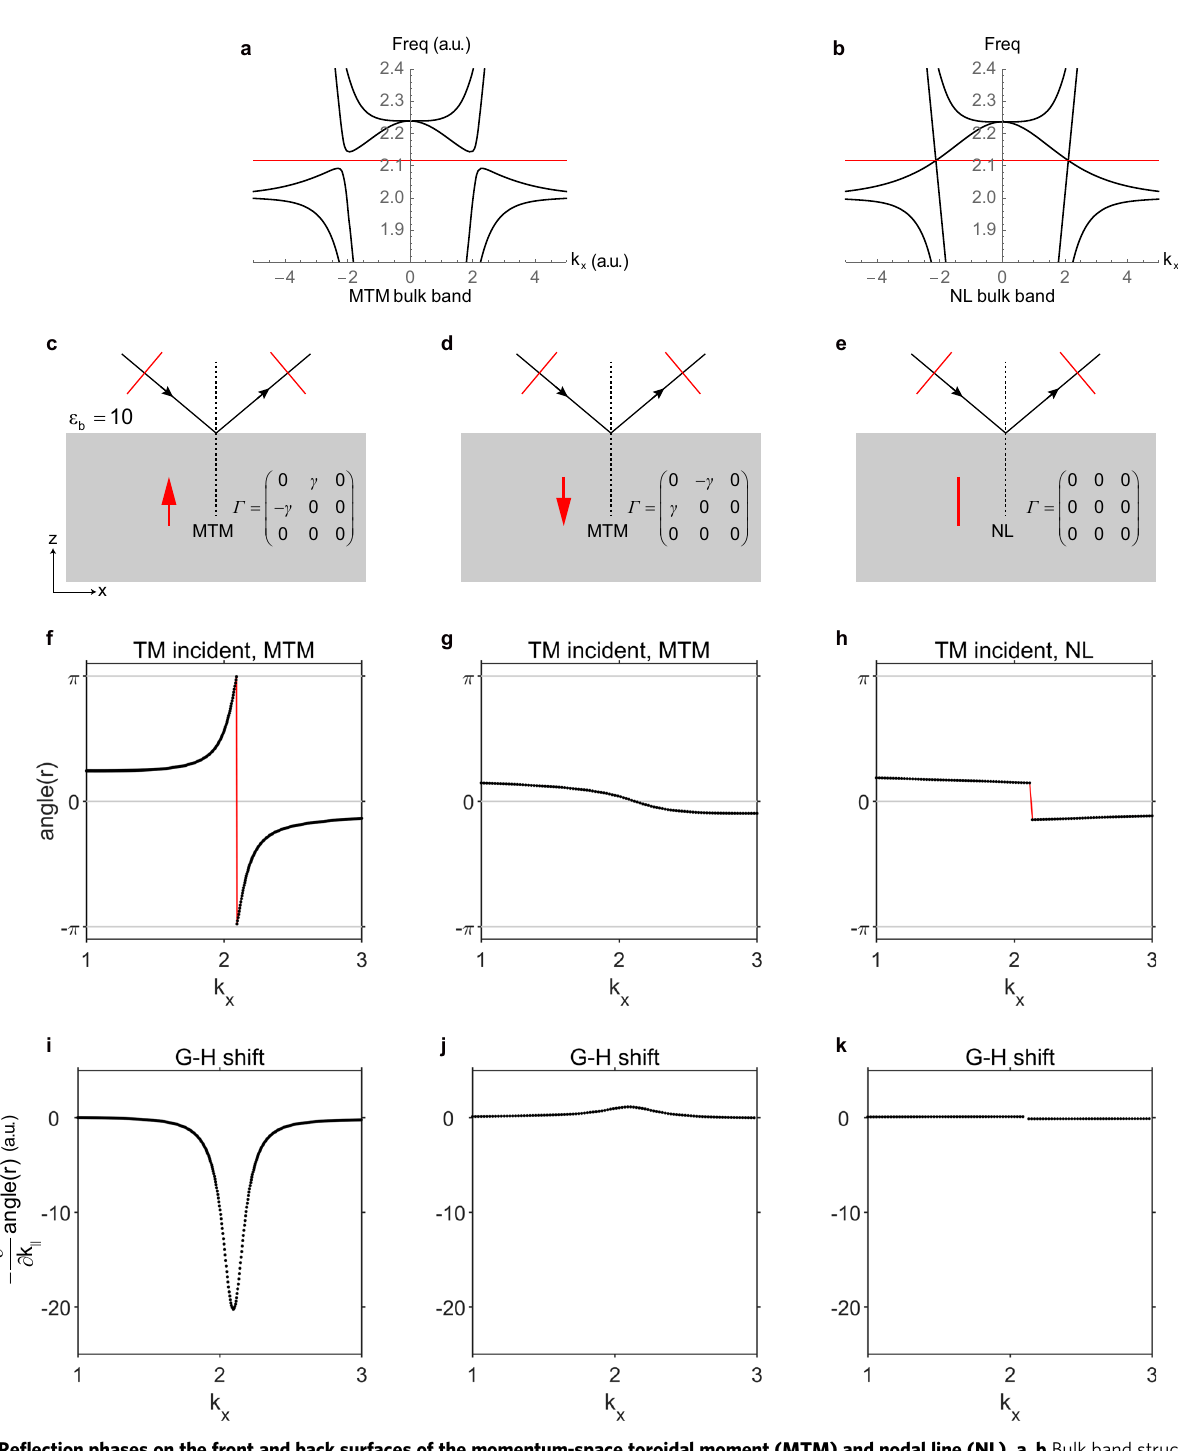
Fig. 5 Re fl ection phases on the front and back surfaces of the momentum-space toroidal moment (MTM) and nodal line (NL). a , b Bulk band structure, the red line indicates the frequency we used in the calculation. c – e The re fl ection con fi gurations. The red arrows indicate the orientations of the MTM. Nodal line is non-orientable indicated with a red line segment. The incident and re fl ected beams are TM (transverse magnetic, H z ¼ 0) polarized as illustrated with thin red line segments. f – h Re fl ection phases for the corresponding three different cases with dielectric constants ε b ¼ 10. i – k The spatial shifts for the re fl ected beams obtained with (cid:2) ∂ ∂ k angle ð r Þ jj